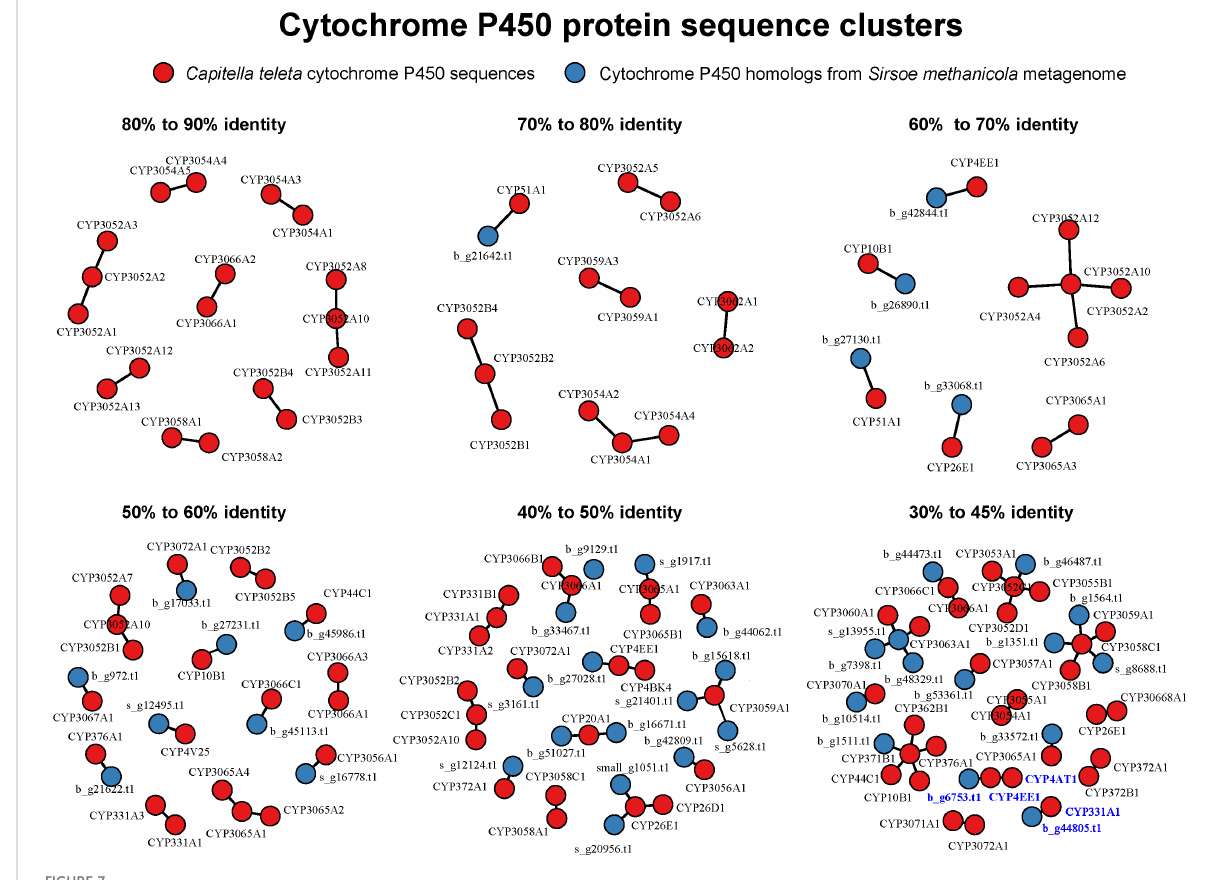
FIGURE 7 Clusters of cytochrome P450 (CYP) protein sequences from Capitella teleta compared to those identi fi ed in the S. methanicola metagenomes, visualized using the igraph R package. Each node represents a protein sequence, and connected nodes represent protein sequences sharing the speci fi ed range of global % sequence identity. Protein sequences in the S. methanicola metagenomes in contigs ≥ 3,000 bp contain the pre fi x b_, while those in contigs <3,000 bp contain the pre fi x s_. Clusters containing protein sequences similar to CYP331A1 and CYP4AT1 in C. teleta are highlighted in blue text. Protein sequences of CYP homologs recovered from the S. methanicola metagenomes are listed in Table